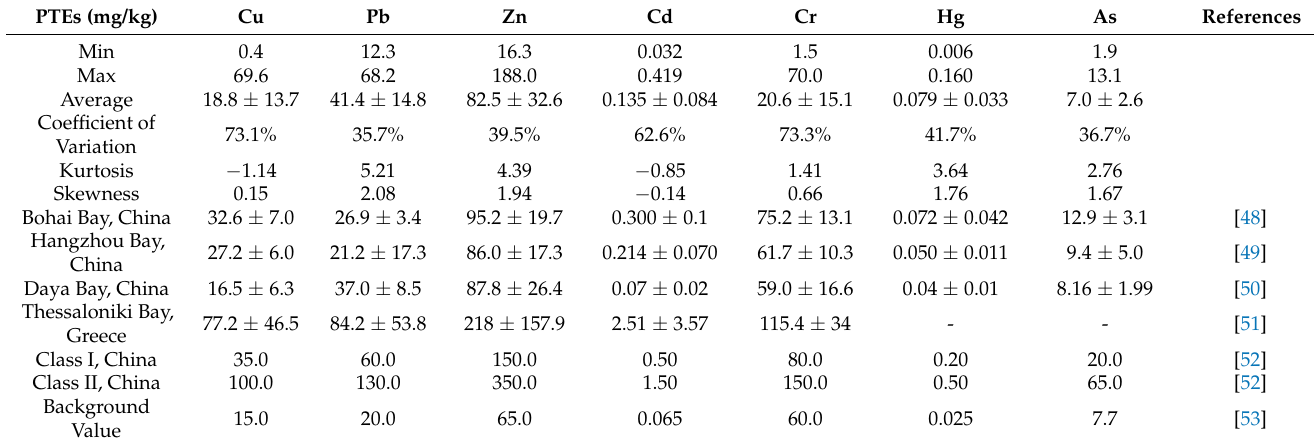
Table 1. Descriptive statistics for PTEs in surface sediment in Xiamen Bay and other